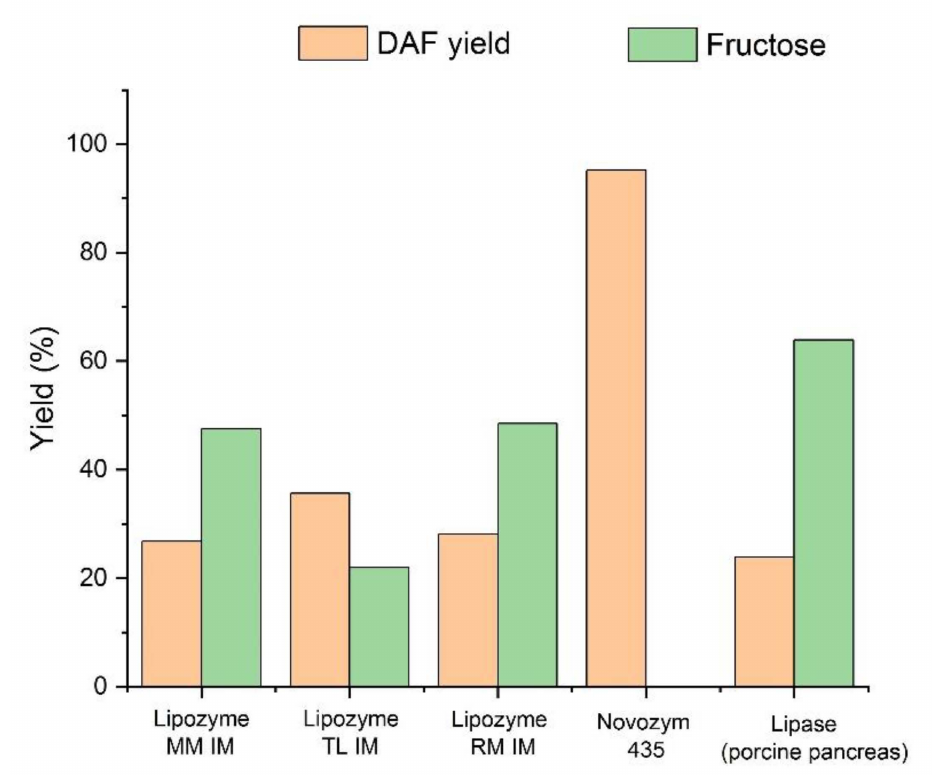
Figure 3. Esterification of fructose with different lipases for DAF